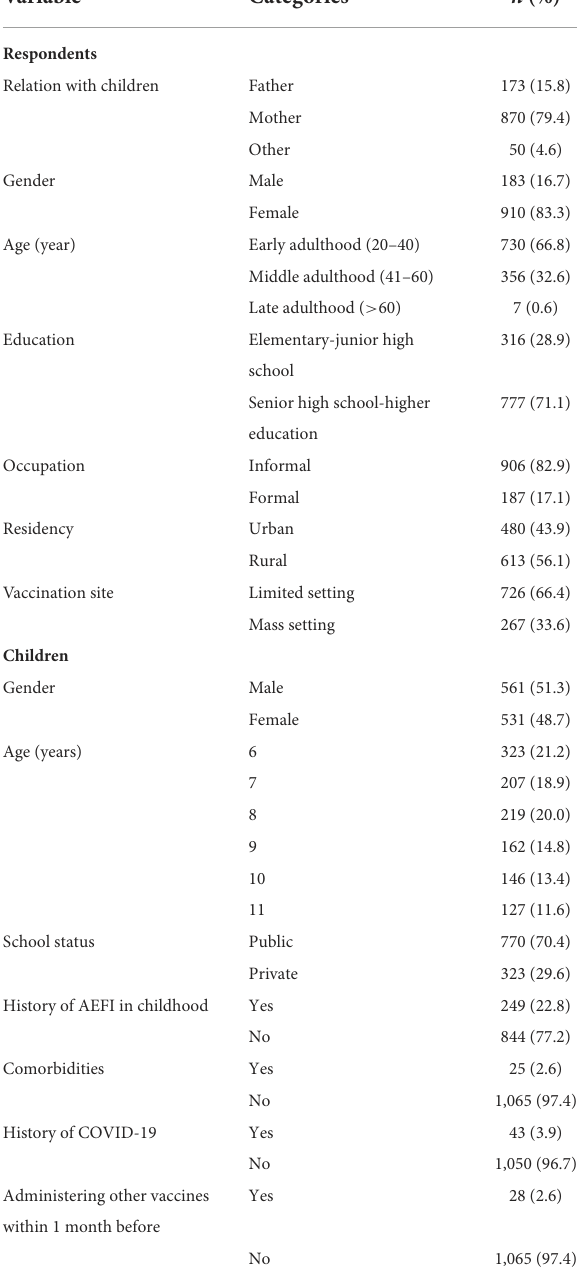
following the first and the second dose of CoronaVac vaccine for children aged 6–11